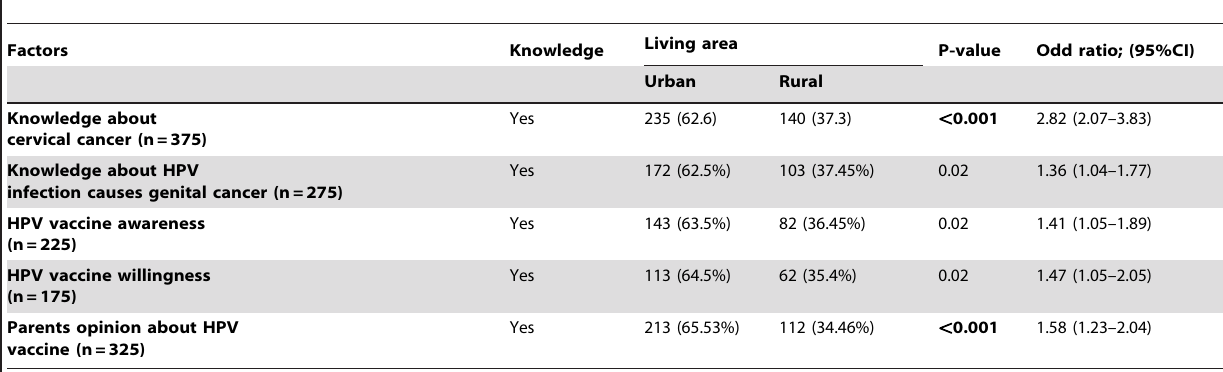
Table 4. Awareness about cervical cancer and HPV according to living